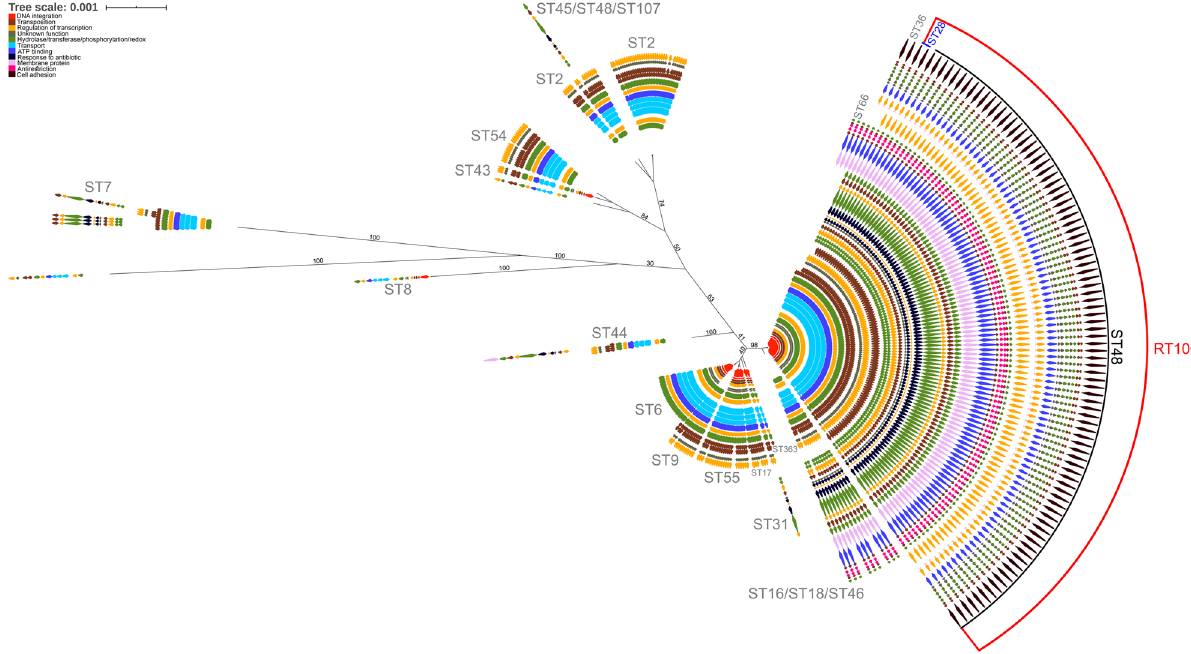
Figure 4. Molecular clock analysis reveals organization of the genomic island 1 via acquisition of distinct sub-elements. A timetree using the 7.1 KB consensus region in the 265 strains highlighted in black dashed box in Fig. 3 may offer clues towards the acquisition of sub-elements leading to the formation of GI1. Divergence times shown are relative times as no calibrations were provided. The estimated log likelihood value of the tree is − 14,227.79. The percentage of replicate trees in which the associated taxa clustered together in the bootstrap test are shown next to the branches. The phylogenetic tree is rooted using CD105KSE6. CD105KSE6 branches most distantly from RT106/ST28/ST42 clade based on alignment of the 7.1 kb region in